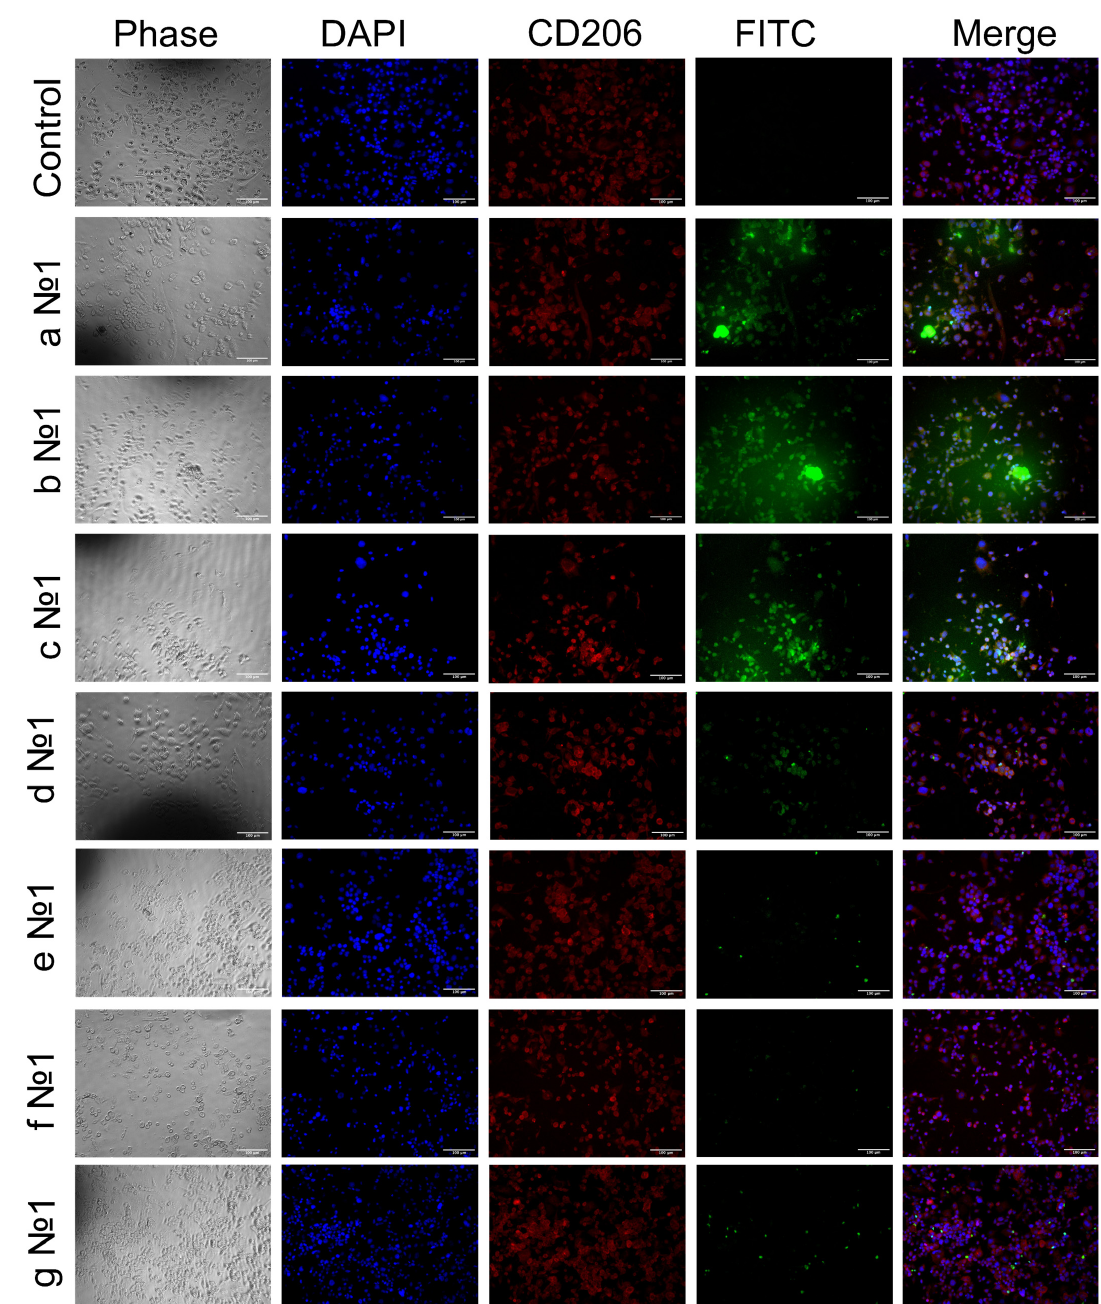
Figure 6. Immunocytochemical evaluation of CD206 in THP-1 derived macrophage-like cells (red channel). Phagocytosis assay with polymers (according to Table S1) at concentration N o 1 conjugated with a FITC fluorescent label after incubation for 40 min (green channel). Two types of polymers: HPCD-PEI1.8 and HPCD-spermine, modified with mannose ( a , e ), trimannose ( b , f ) or galactose ( c , g ), respectively, and one sample HPCD-spermine modified with mannan ( d ). Phase contrast microscopy, fluorescent microscopy, blue channel—nuclei stained with DAPI. Scale bar, 100 µm.